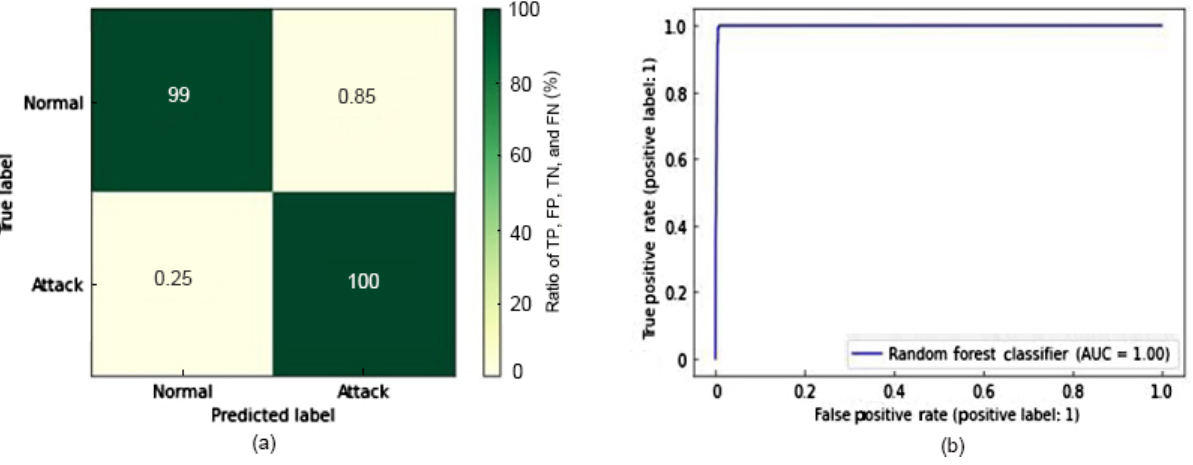
Fig. 13 Confusion matrix and ROC curve of RF-IF on the NF-UNSW-NB15-v2 dataset.